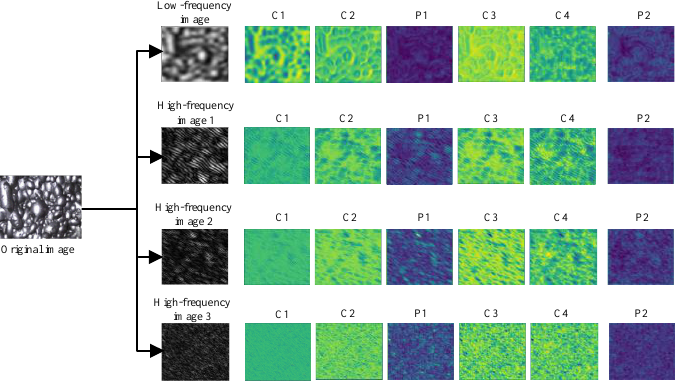
Figure 12. Visualization results of CNN features.